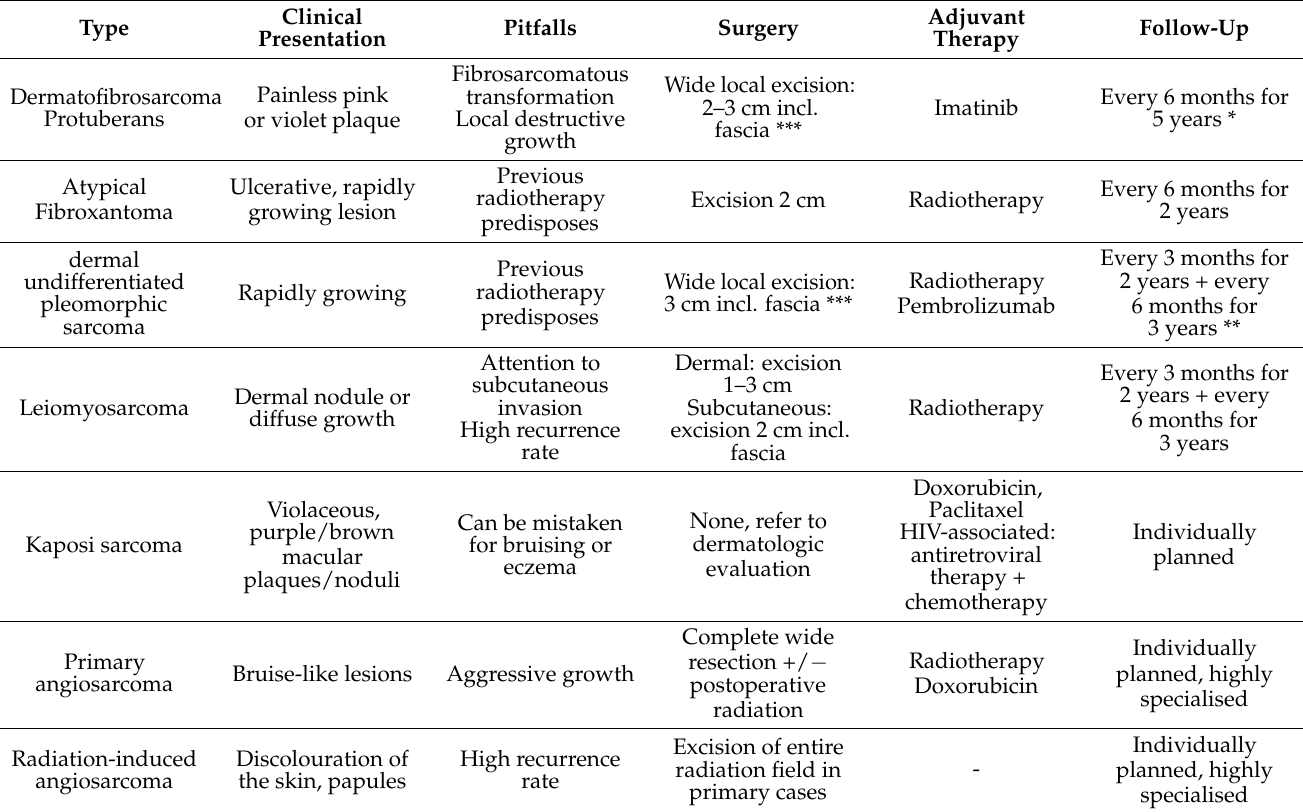
Table 1. An overview of PDS and important clinical